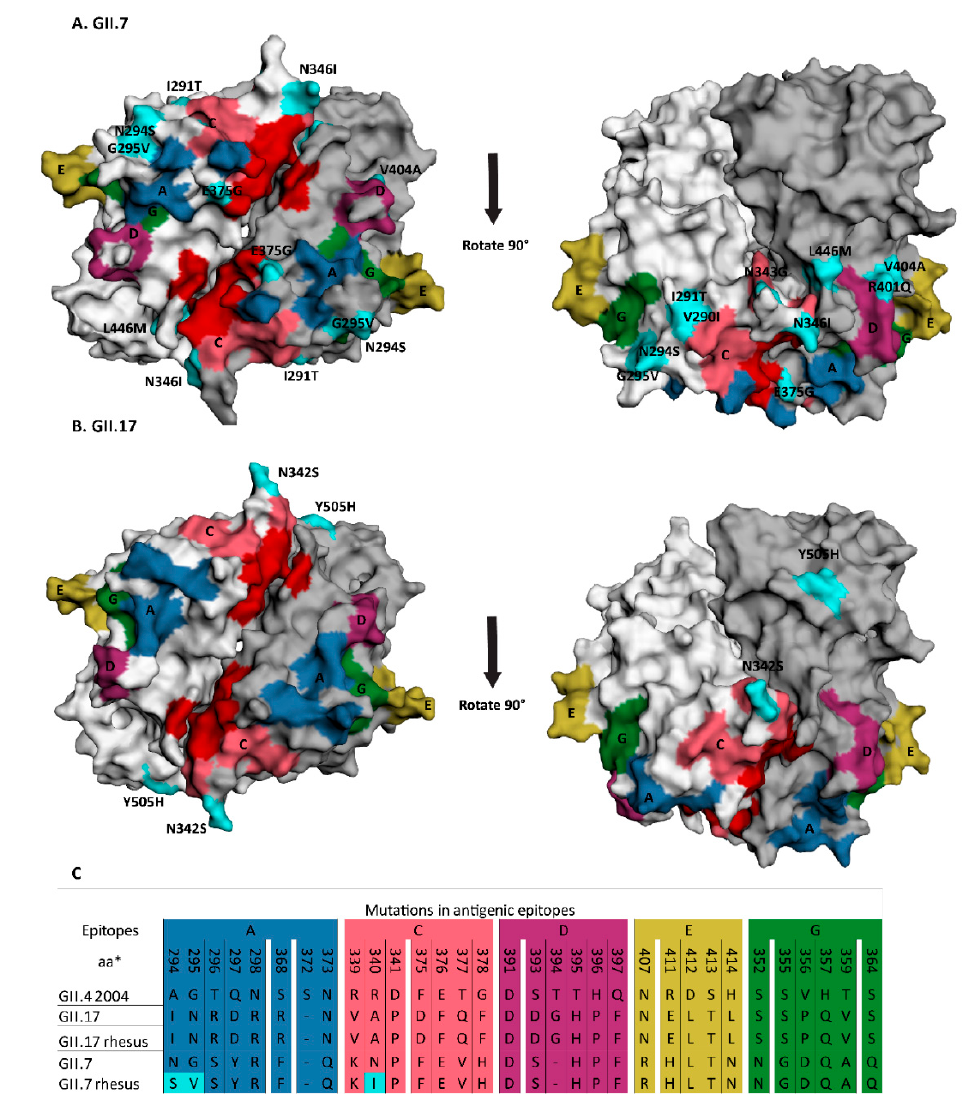
Figure 5. Mapping of amino acid di ff erences between human strains found in animals versus humans onto p-dimers (the two subunits are shown in two shades of grey, top-view). Amino acid changes exclusively found in the strains detected in animals are colored in turquoise. Predicted HBGA binding sites are marked in red, and the epitopes A-G in color. Changes were mapped onto the p-domain GII.7 3D structure predicted by SWISS-MODEL on the basis of the crystal structure of the p-domain of a GII.17 strain (PDB number 5f4o.1) for GII.7 (KT943504 and KT943505) ( A ) and GII.17 Kawasaki (5LKG) for GII.17 (KX356908) ( B ). The alignment was performed with MEGA ClustalW and shows the amino acids defining the antigenic sites [17] that di ff er between strains found in animals and humans ( C ). Amino acid numbering was based on GII.4 2004. Putative binding sites were taken from reference